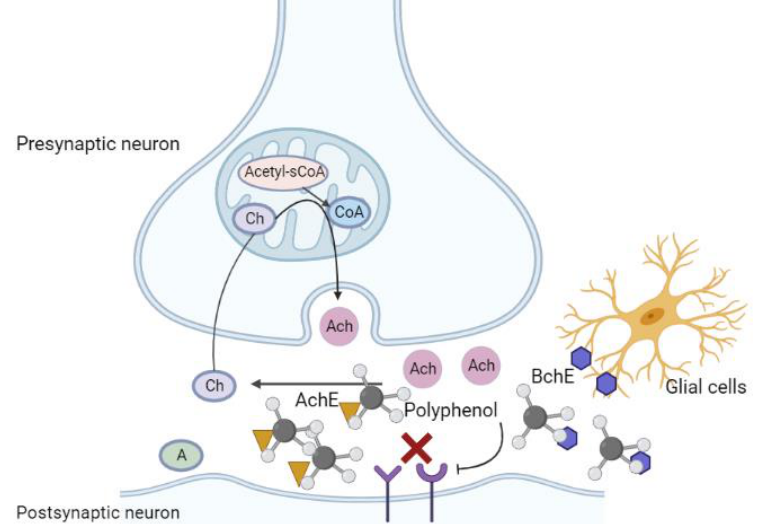
Figure 5. Regulatory role of polyphenols in the context of cholinergic injury: polyphenols inhibit the binding of cholinesterase to receptors, reduce cholinesterase activity, reduce Ach hydrolysis, restore the cholinergic level in the brain, and alleviate AD symptoms. Ach, acetylcholine; AchE, acetyl cho- linesterase; BchE, butyrylcholinesterase.